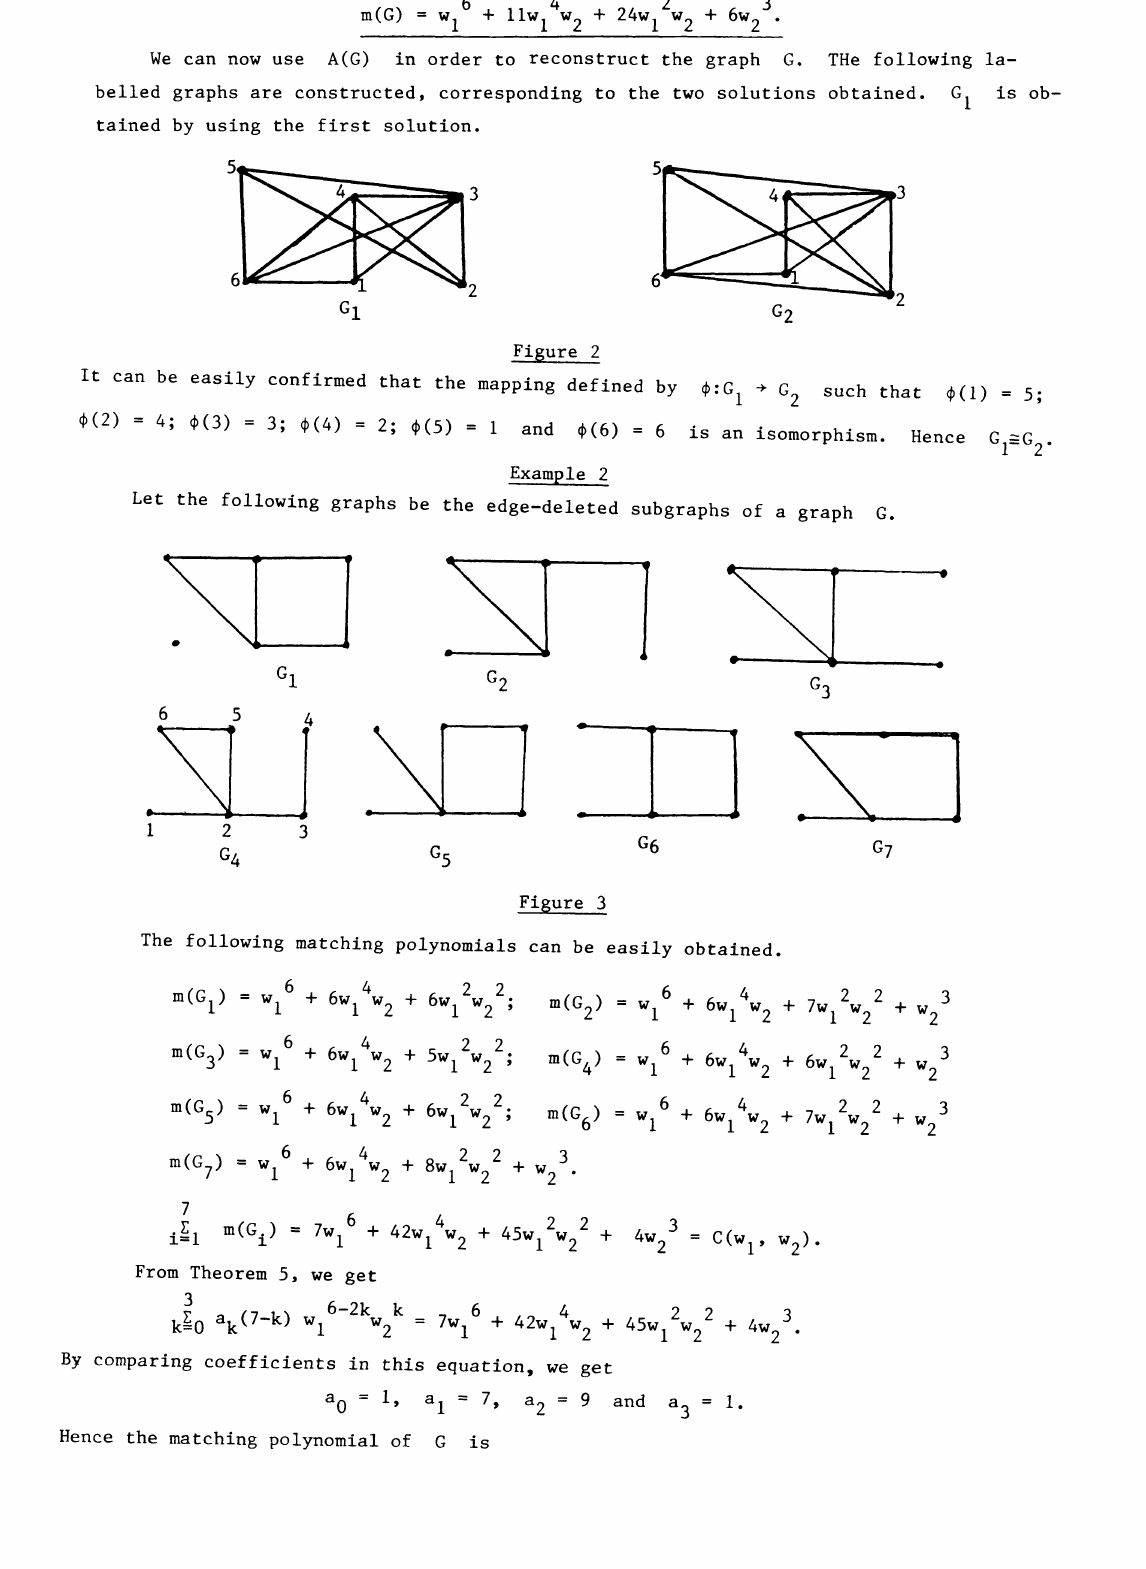
Figure 2 mapping defined by